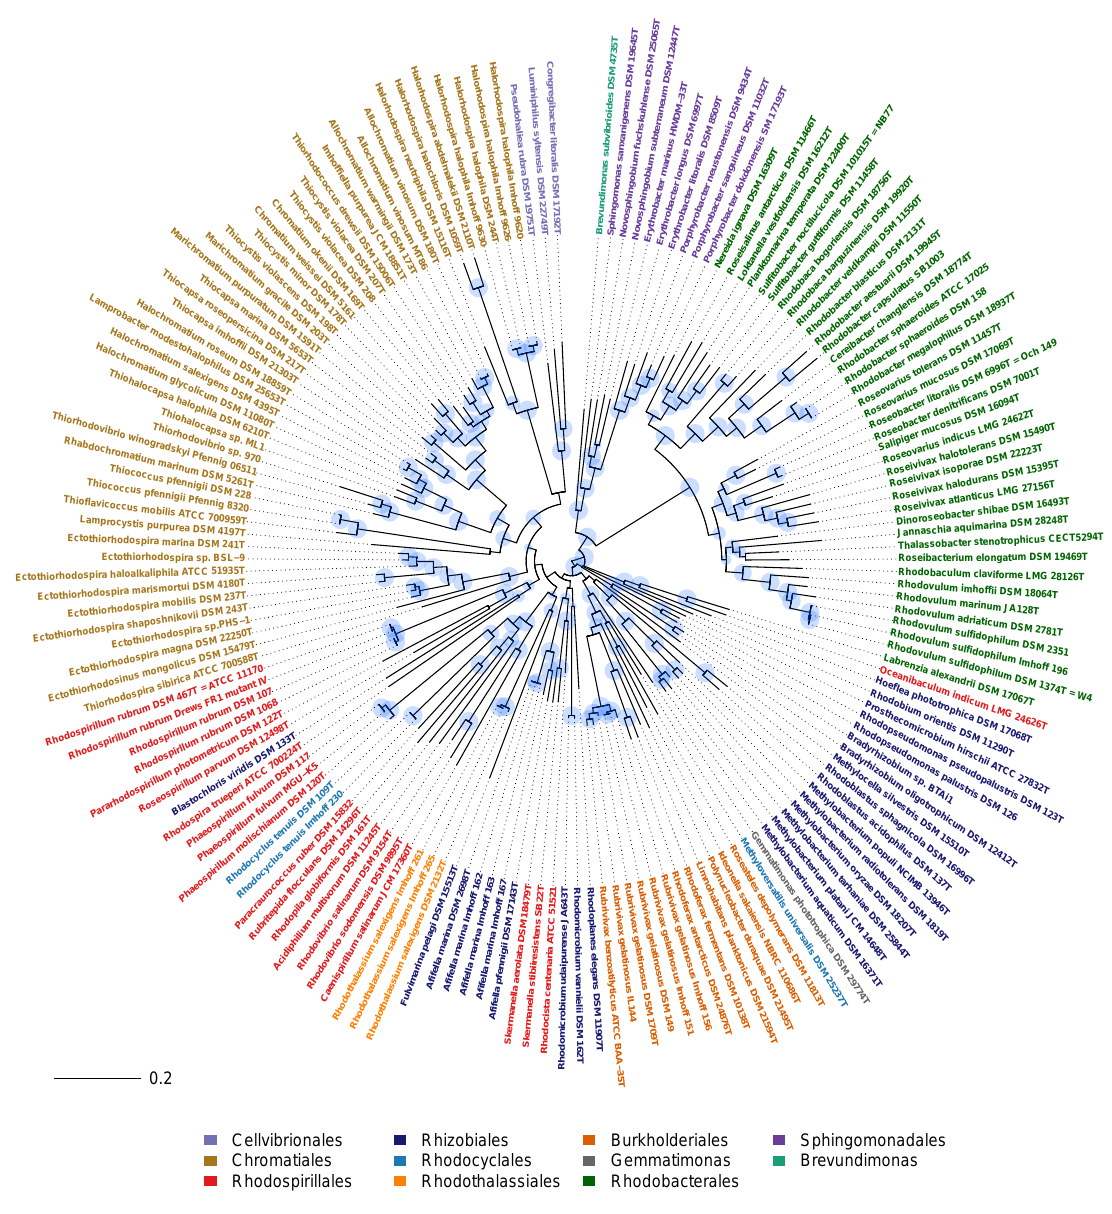
Figure 3. Phylogenetic tree (PS tree) of phototrophic bacteria, according to BchXYZ-PufHLM